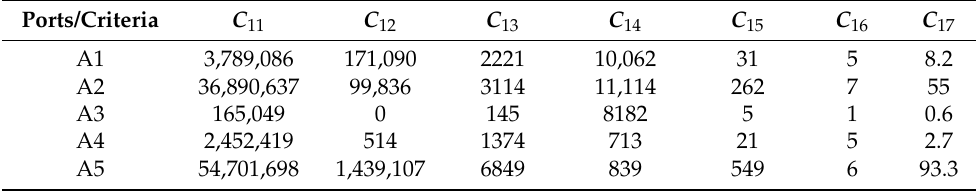
Table 4. Decision matrix for economic criteria .